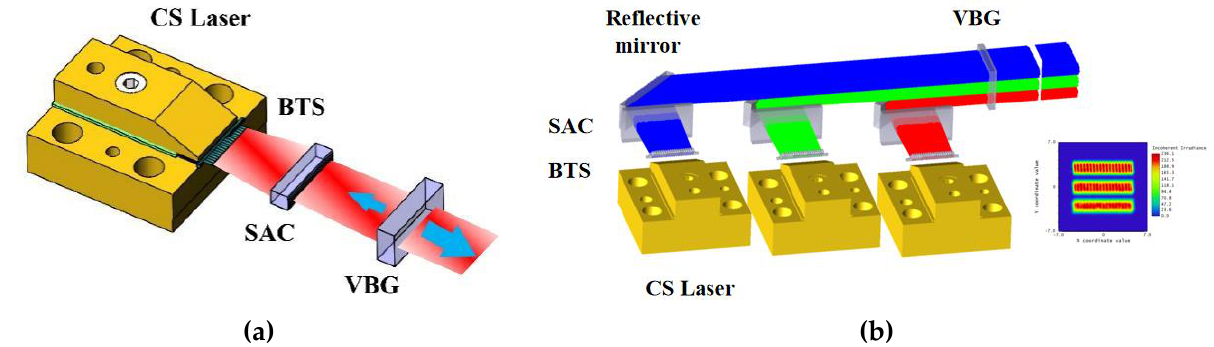
Figure 1. Schematic diagram for ( a ) the external cavity diode laser structure and ( b ) the beam shaping and spectrum control. Table 2. Typical parameters of a laser chip. Parameters Unit Specifications